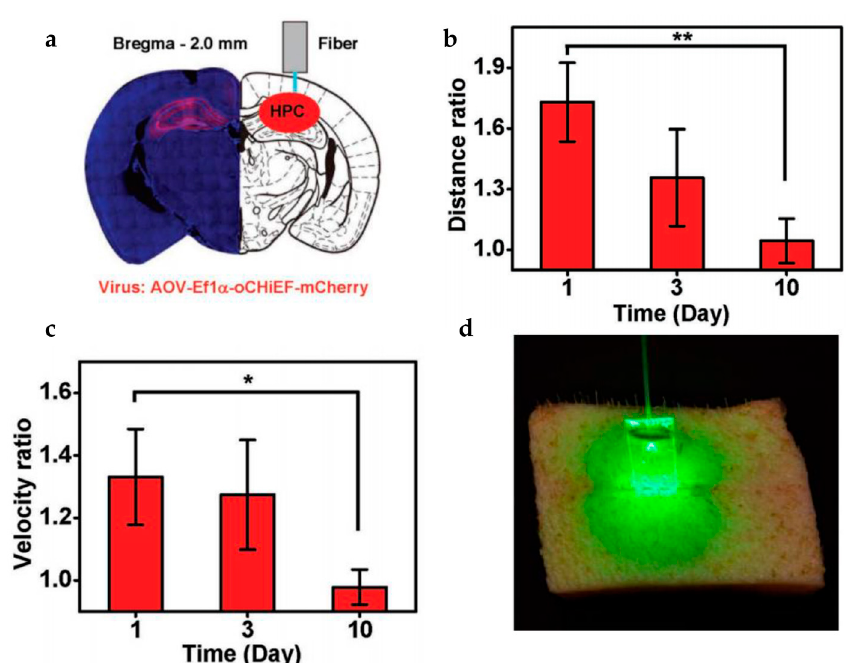
Figure 8. ( a ) Confocal microscope image obtained from a coronal section of a mice model containing enhanced green fluorescence protein two weeks after the viral transfection ( left ) and schematic diagram of a bioresorbable fiber that was implanted into the hippocampus ( right ). ( b ) The ratio of travelling distance with the laser on and off, varying with the in vivo dissolution of bioresorbable fibers (**). ( c ) The ratio of velocity with the laser on and off, varying with the in vivo dissolution of bioresorbable fibers (*). ( a – c ) Reproduced with permission from [51]. ( d ) Optical image of a porcine skin incision illuminated with an inserted waveguide by a green light to promote wound healing. Reproduced with permission from [52]. The symbols (*) in the bar chart are used to indicate the degree of difference, where ”**” represents the significance probability (p) < 0.01 and ”*” means 0.01 < p <